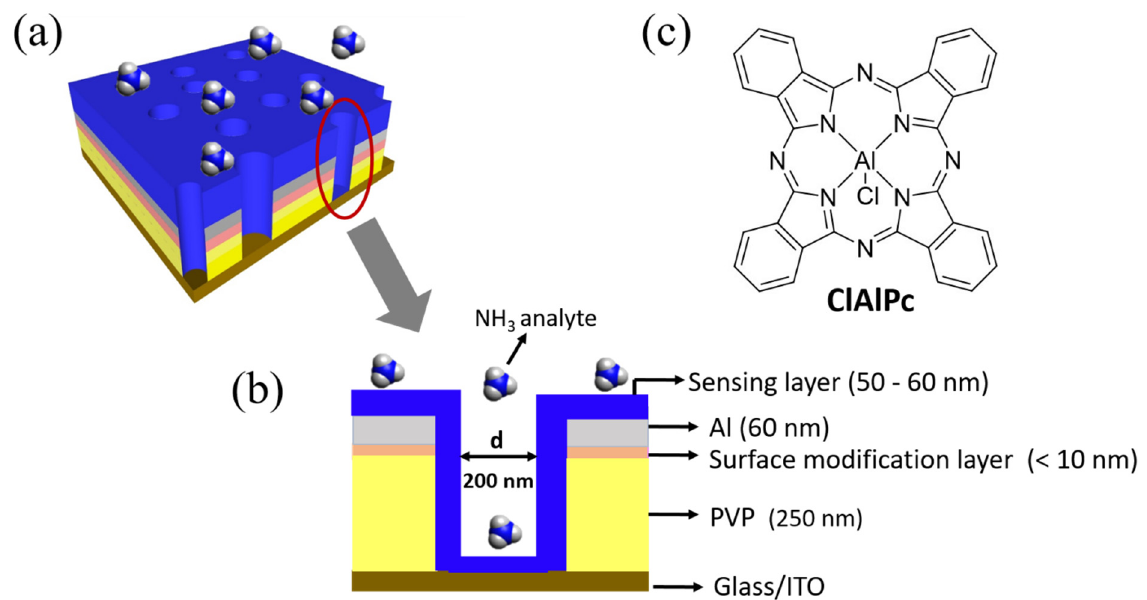
Figure 1. ( a ) Schematic illustration of fabricated vertical organic diode (VOD) sensor. ( b ) Cross-section view of the VOD device. ( c ) Molecular structure of ClAlPc.